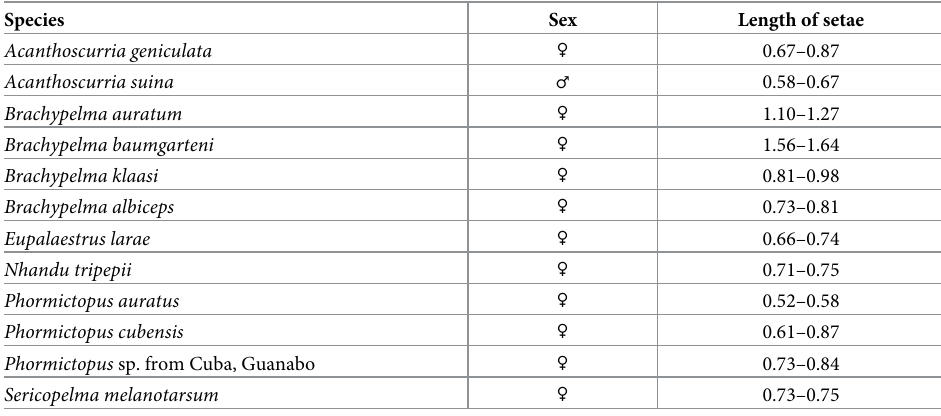
Table 5. Length ranges of subtype I c setae.